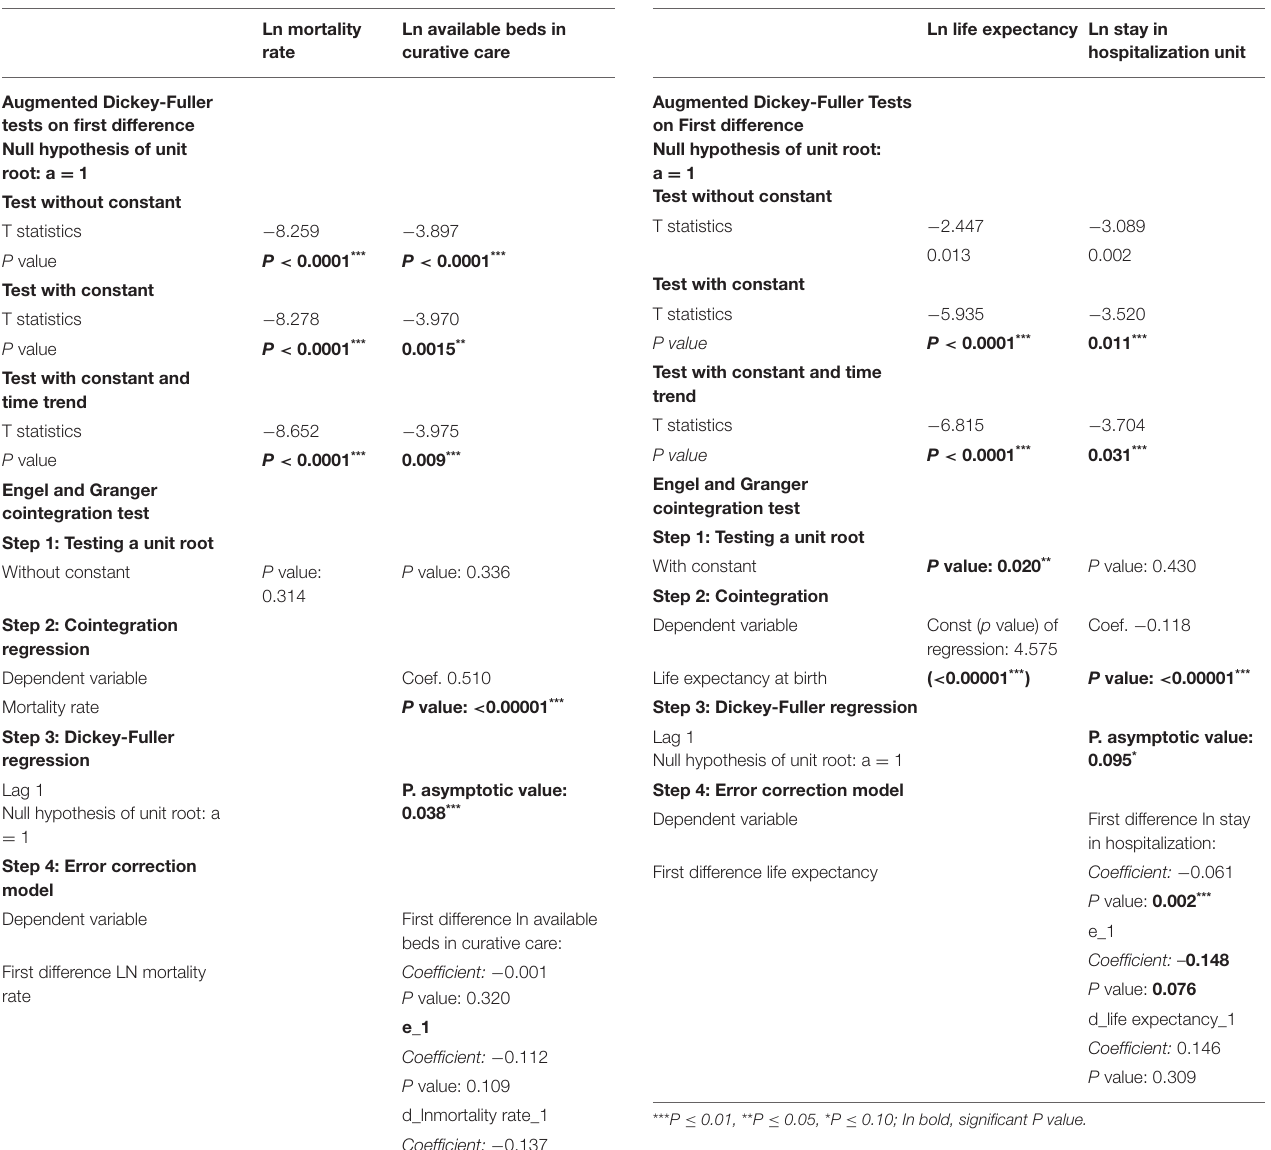
TABLE 5 | Engle Granger cointegration test between mortality rate and bed occupancy rate in the period 1970–2018.